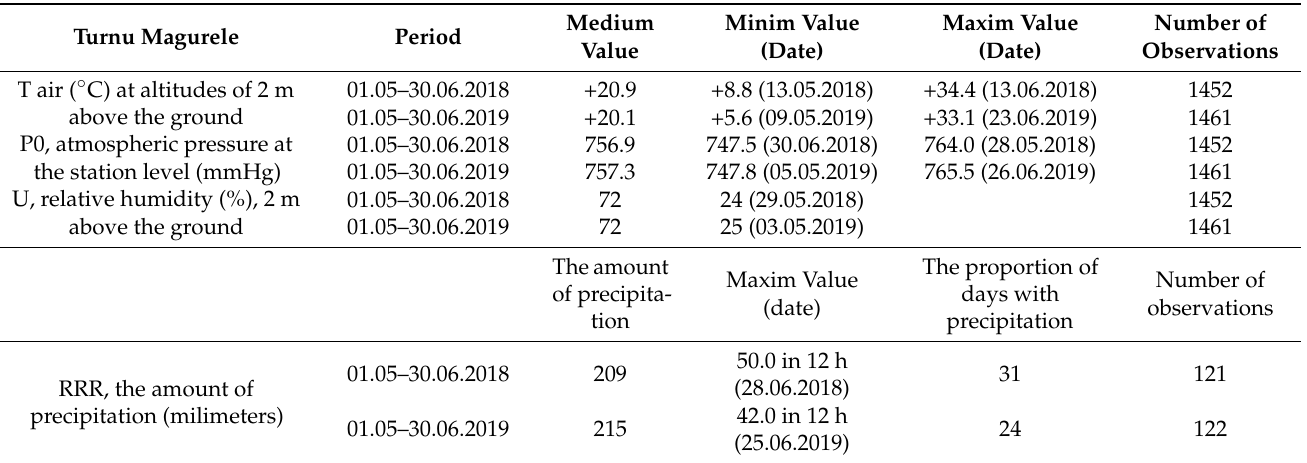
Table 1. Climatic conditions in Turnu Magurele town (Romania) during 2018–2019 according to ANM (National Weather Service)